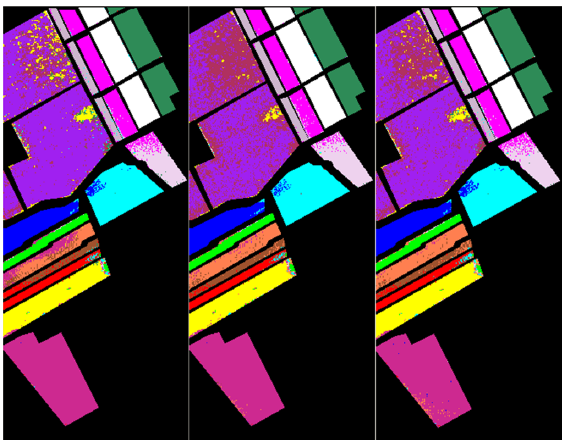
Figure 6: Synergetics classification with different attention pa- rameters settings. From left to right the λ parameters are set as follows: all parameters set to 1, parameters adjusted on the basis of the full ground truth, parameters tuned using a training area for each class.